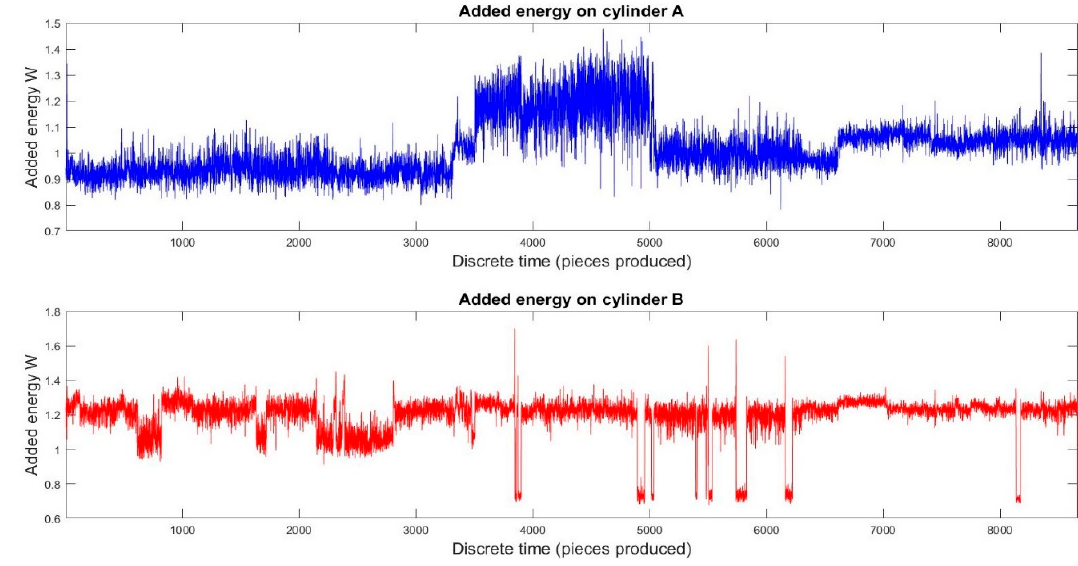
Figure 7. Indicative added energy W time-series.